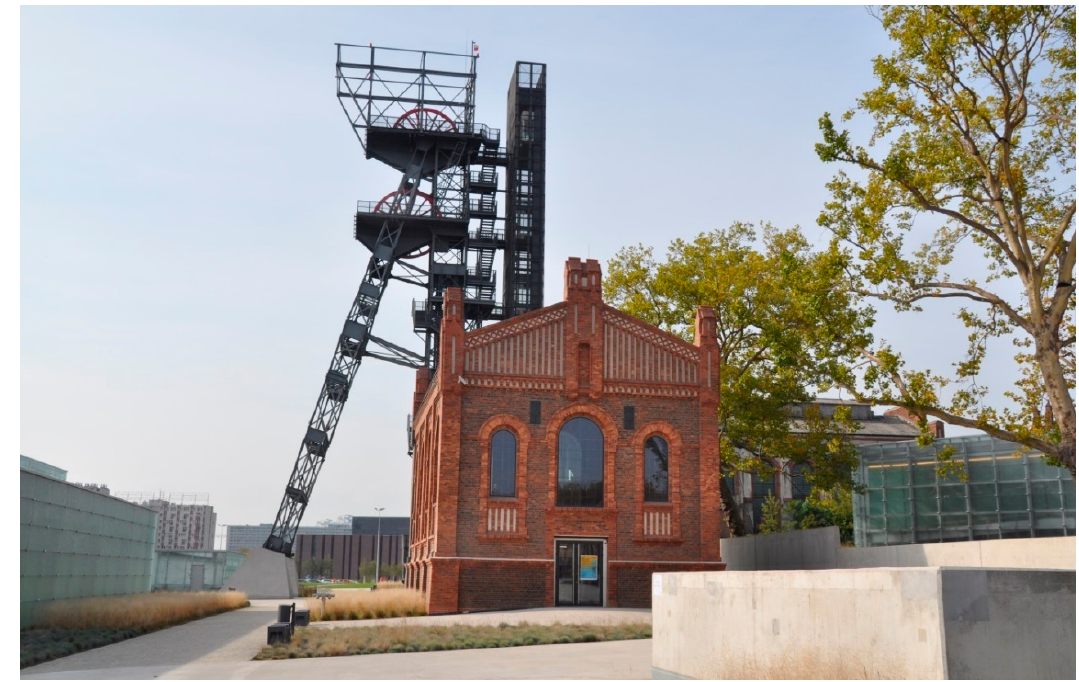
Figure 2. The “Warszawa” shaft lift engine house converted into a restaurant, the lift tower with a viewing platform, and the newly erected facilities (photo: A. Ostr ę ga).